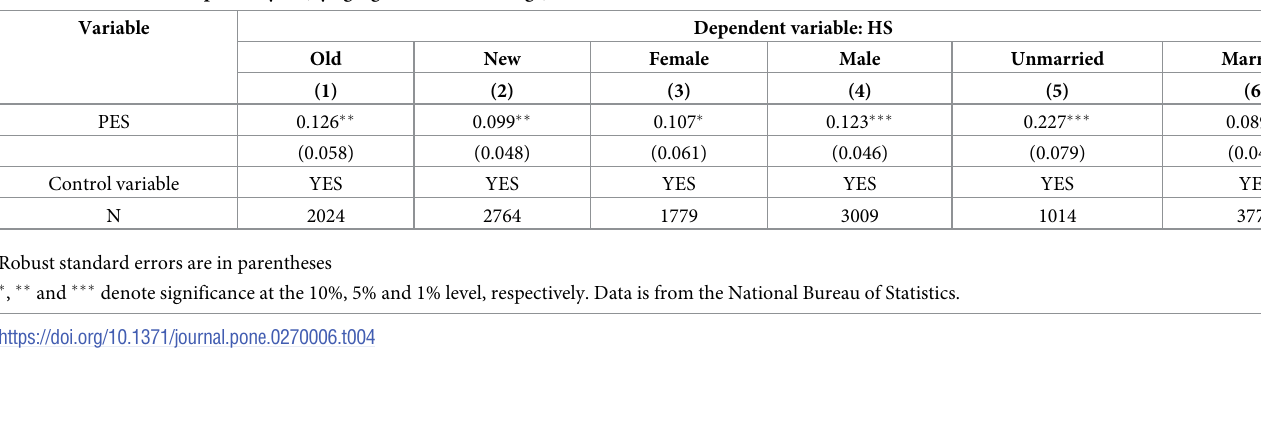
Table 4. Subdivided sample analysis (by age, gender and